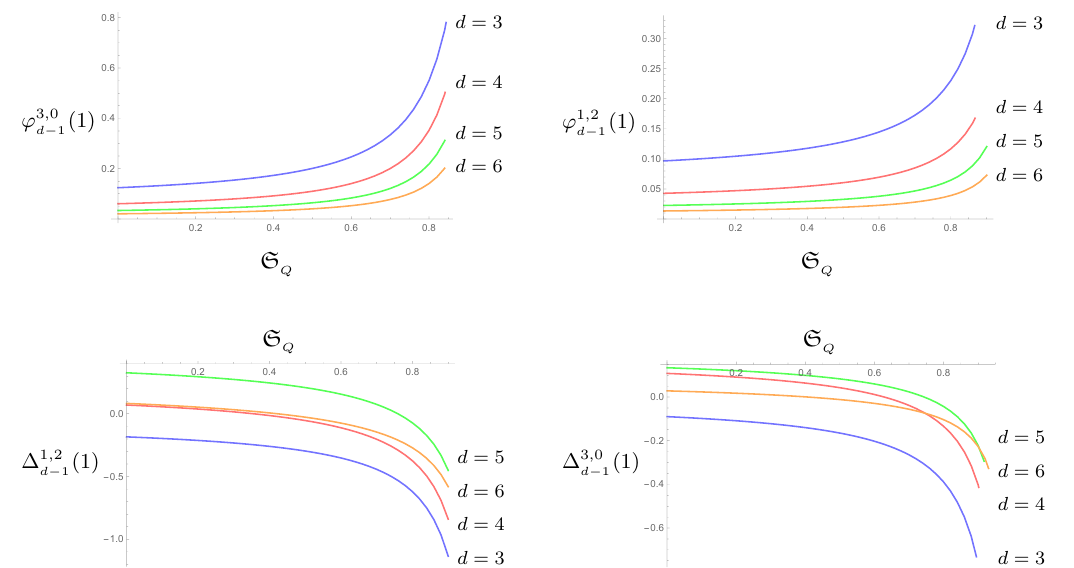
Figure 7 . The charge dependence of the coefficients at the quartic order Green’s function of the Markovian tensor graviton polarizations and the non-Markovian momentum diffusion part of vector modes in various dimensions, supplementing the lower order coefficients depicted in figure